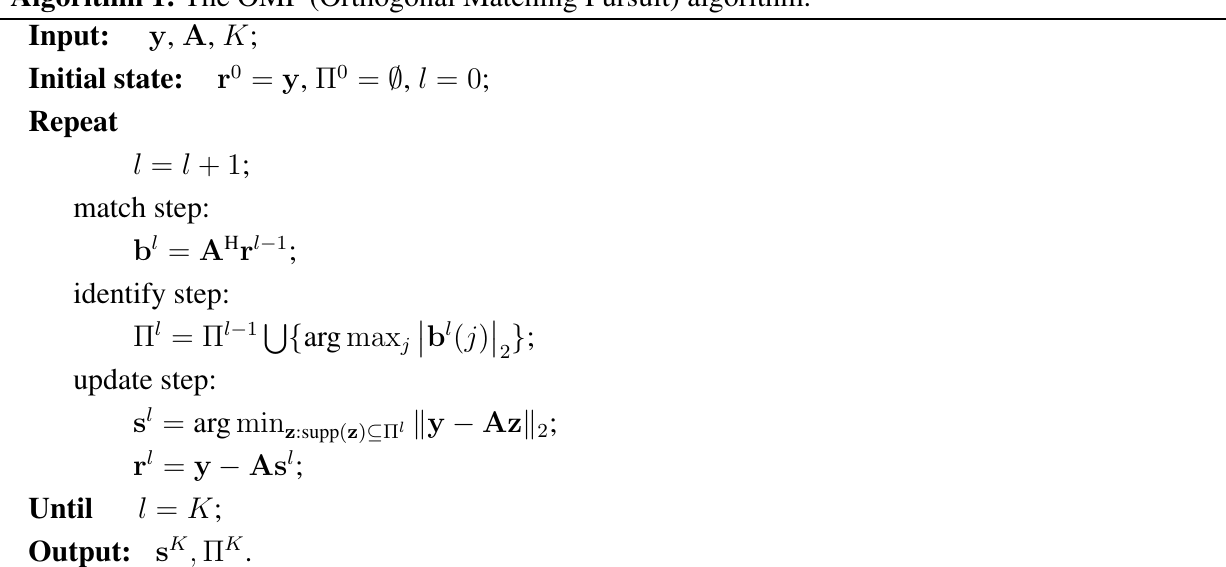
Algorithm 1: The OMP (Orthogonal Matching Pursuit)